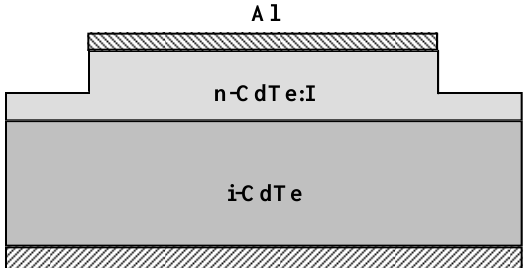
Figure 8. Schematic of the Al/n-CdTe:I/i-CdTe/Pt structure. The n-CdTe:I layer below the Al electrode is 2 µm